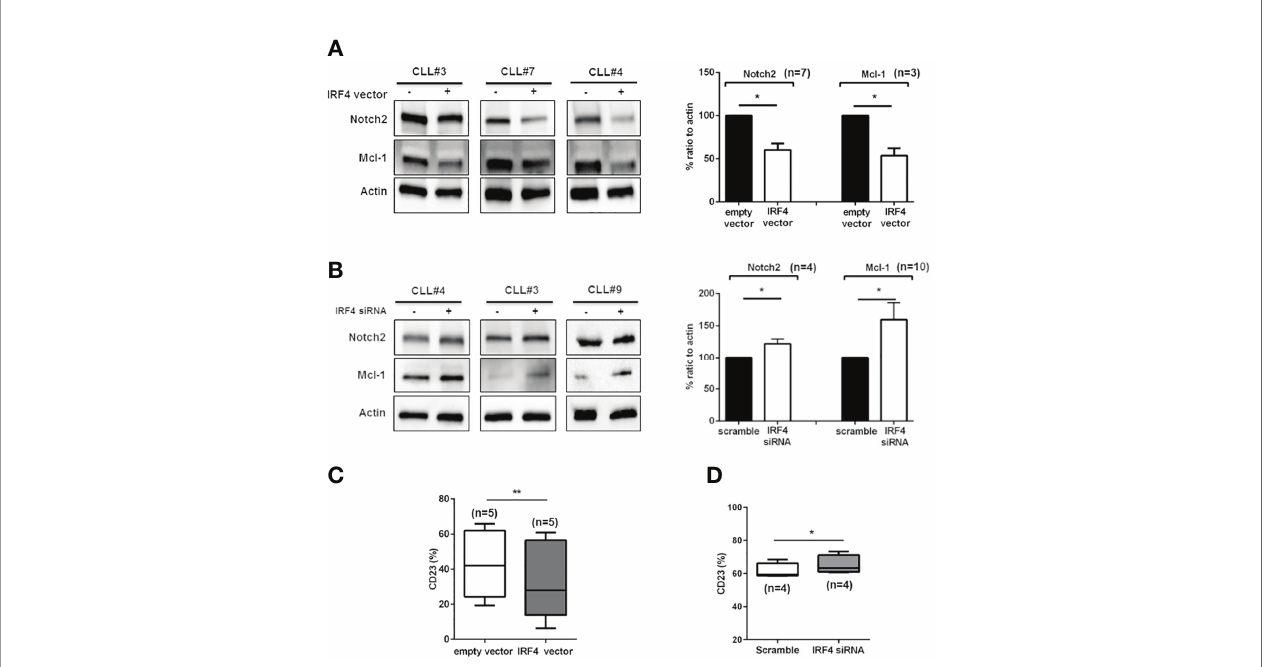
FIGURE 2 | Notch2 and Mcl-1 expression in trisomy 12 is modulated by IRF4. (A) Puri fi ed trisomy 12 chronic lymphocytic leukemia (CLL) cells were transfected with an empty vector or with IRF4 vector and cultured in complete medium for 24 h. Immunoblots show Notch2 and Mcl-1 expression in three representative trisomy 12 CLL patients. On the right, bar diagrams show the densitometric quanti fi cation of Notch2 and Mcl-1 in +12 CLL cells transfected with an empty vector or IRF4 vector for 24 h (*p < 0.05). (B) Trisomy 12 CLL cells were silenced for IRF4 expression for 24 h. Immunoblots show the expression of IRF4 Notch2 and Mcl-1 after transfection with scramble or IRF4 siRNA in three representative samples. On the right, bar diagrams show densitometric quanti fi cation of Notch2 and Mcl-1 in +12 CLL cells after 24 h of transfection with IRF4 siRNA for 24 h (*p < 0.05, **p < 0.01). (C) Box plot shows the expression of CD23 measured by fl ow cytometry after transfection with empty or IRF4 vector for 24 h (**p < 0.01). (D) CD23 expression was measured after transfection of IRF4 siRNA or scramble control for 24 h (*p < 0.05).